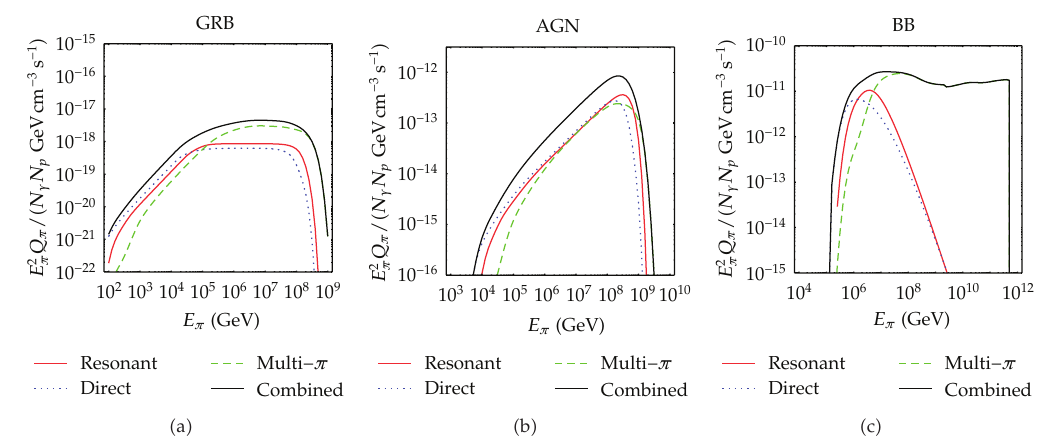
Figure 1: Contributions of di ff erent π (cid:8) production modes to the total spectrum for a typical GRB, an AGN, and a (cid:3) 10eV (cid:4) black body (cid:3) BB (cid:4) target photon density, figure taken from (cid:5) 28 (cid:6)